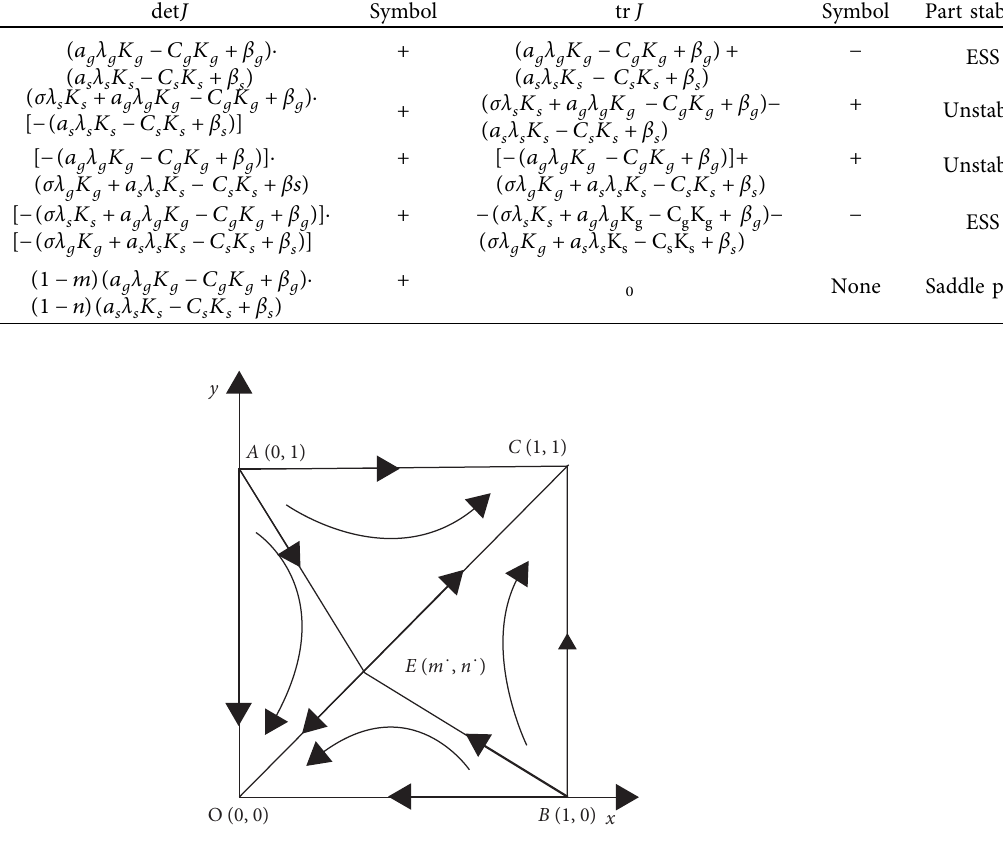
Figure 1: Dynamic evolution of the system in Scenario 1. Table 3: Local stability analysis results of Scenarios 2, 3, and 4.